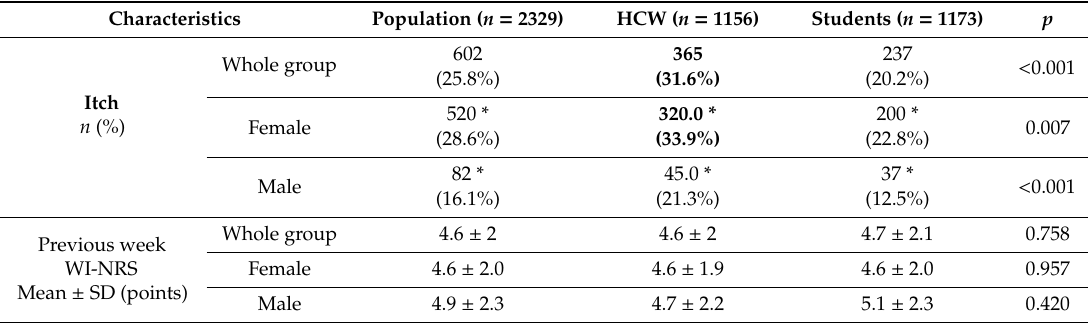
Table 2. Characteristics.